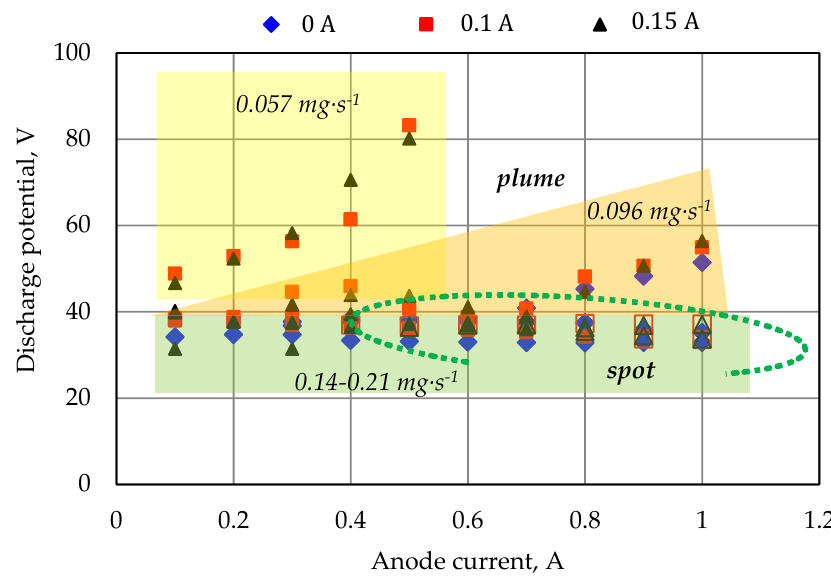
Figure 14. Knife-edge emitter cathode operational characteristics: in standalone mode, in diode configuration with 0 A of keeper current and in triode configuration with a keeper current of 0.1 A and 0.15 A. The closed and open symbols stand for operation in plume and spot mode, respectively, according to the discharge current oscillation criterion. The cathode heater power is 34 W.